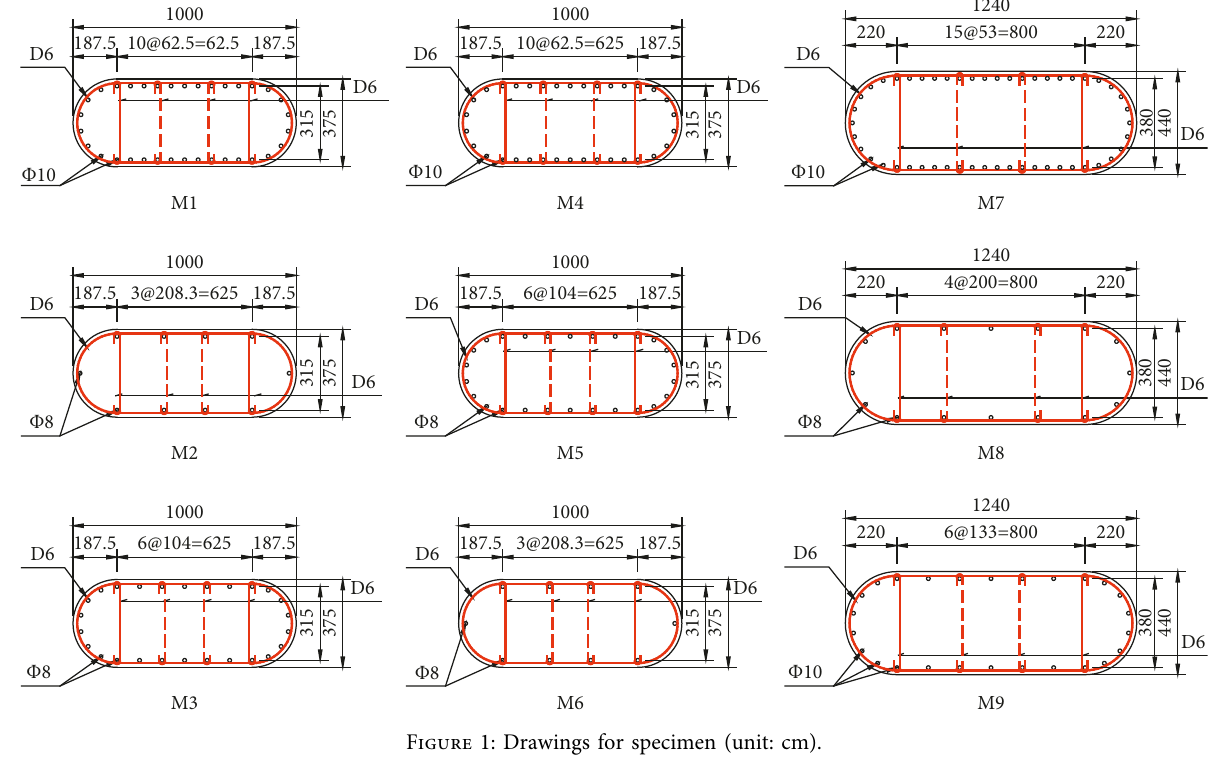
Figure 1: Drawings for specimen (unit: cm).